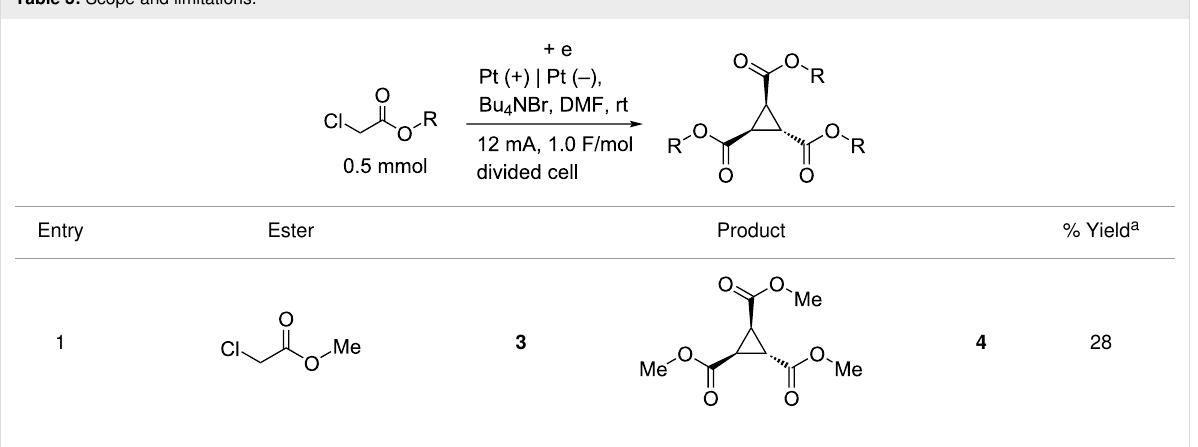
Table 3: Scope and limitations.